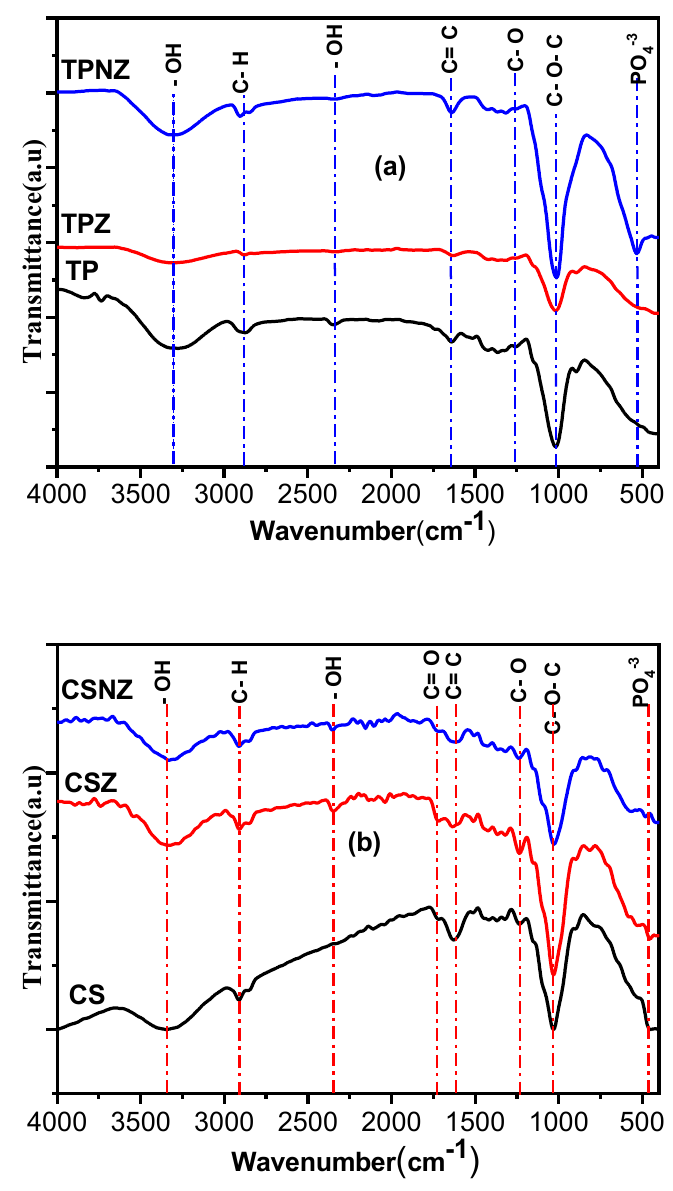
Figure 5. FTIR spectra of ( a ) TP and ( b ) CS, before and after pretreatment.